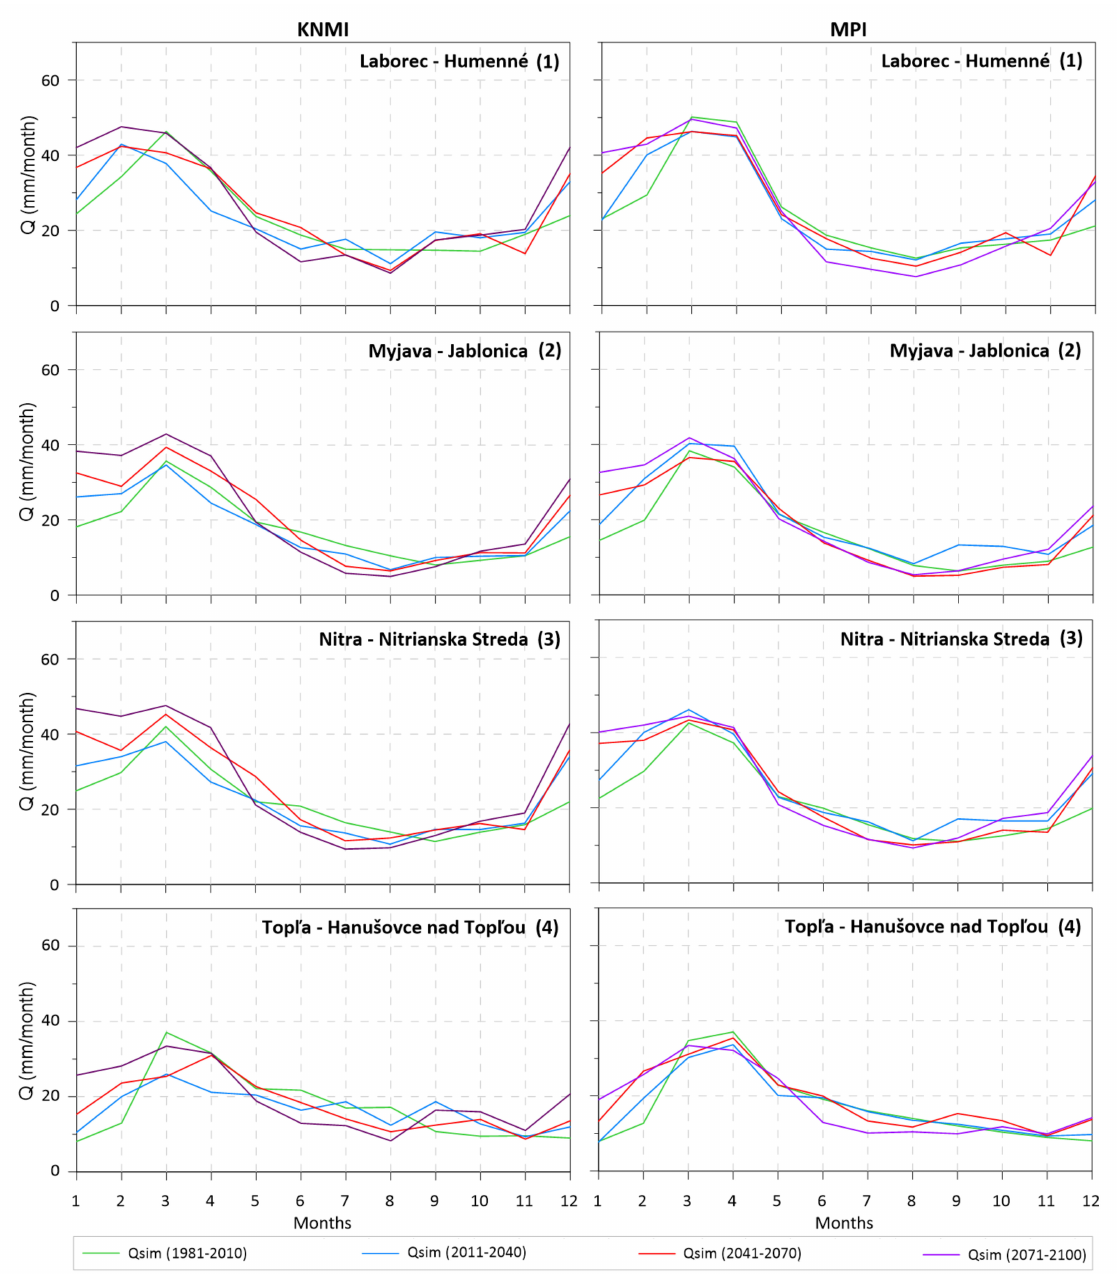
Figure 6. Long-term mean monthly runoff projected for the reference period (1981–2010) and three future time hori- zons (2011–2040, 2041–2070, 2071–2100) according to the KNMI and MPI scenarios for the river basins with a mean elevation < 435 m